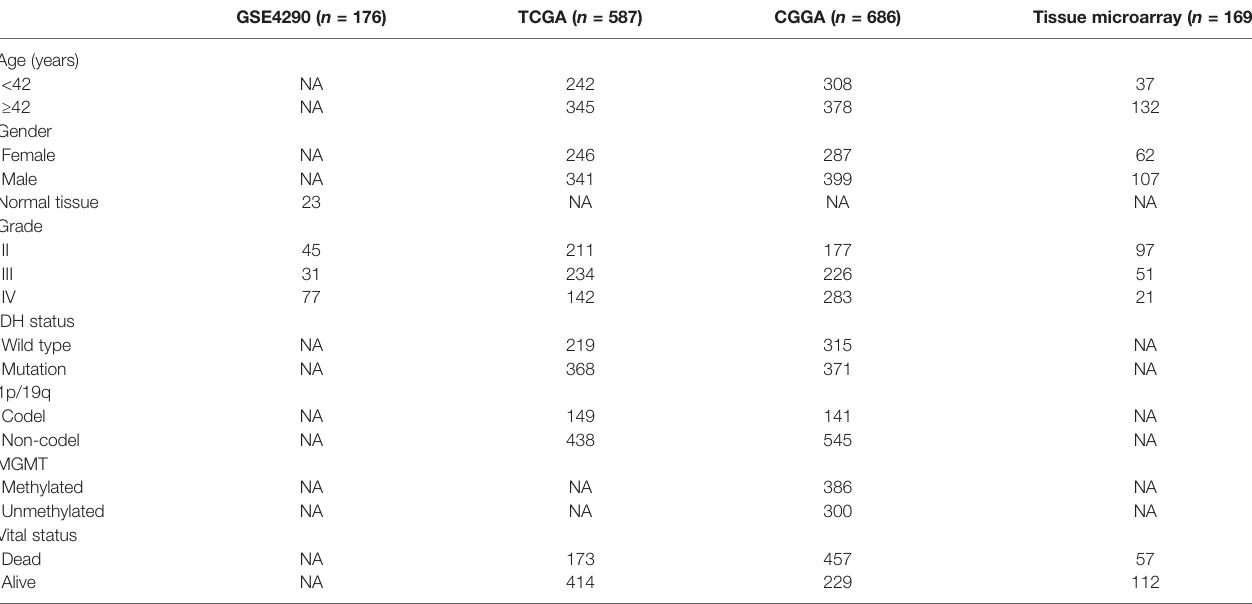
TABLE 1 | Clinicopathological characteristics of glioma patients from the Gene Expression Omnibus (GEO), The Cancer Genome Atlas (TCGA), and the Chinese Glioma Genome Atlas (CGGA) databases and tissue microarray.